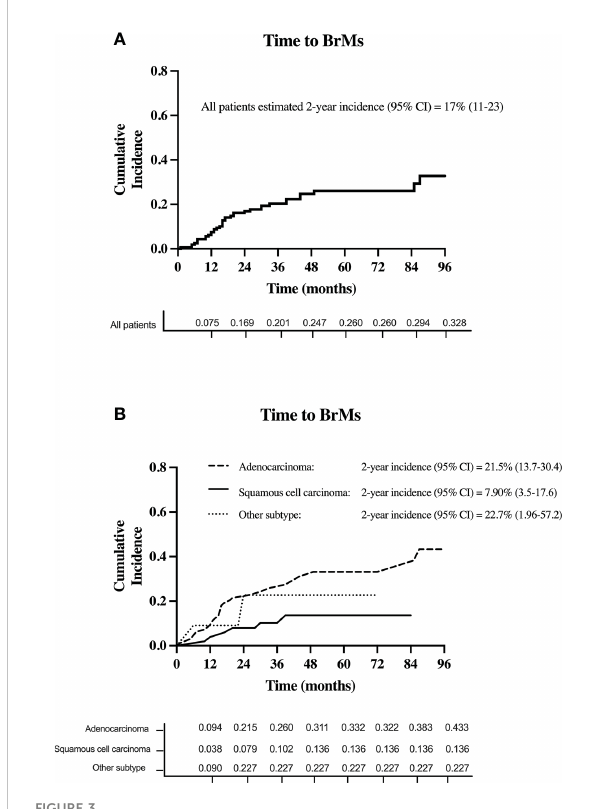
FIGURE 3 The cumulative incidence of BrMs in (A) all patients with stage III NSCLC and (B) for each stage III NSCLC histology